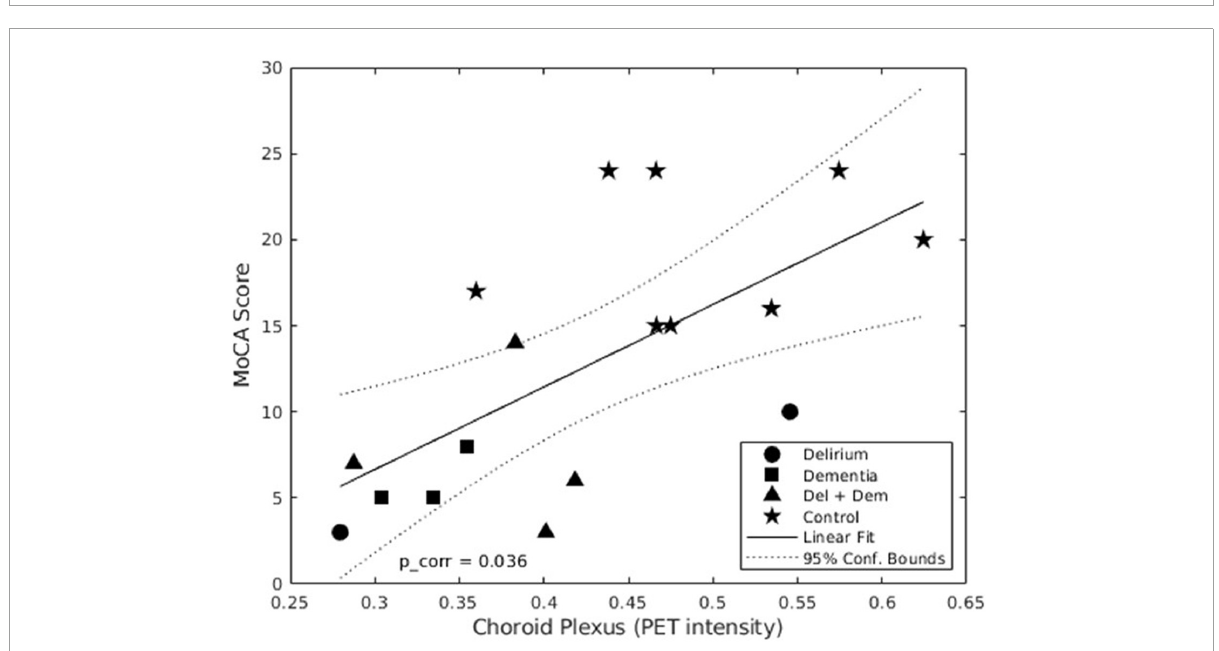
FIGURE2 Linear regression of mean distribution volume ratio (DVR) in choroid plexus and MoCA scores. In this graph we show that there is a positive linear relation between the MoCA score and the mean choroid plexus DVR. This means that the highest DVR intensity in the choroid plexus corresponds to a better cognitive performance by the patients enrolled in the